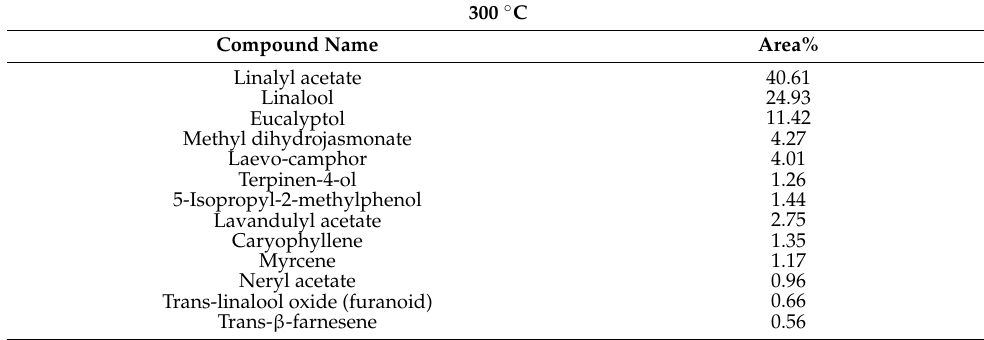
Table 2. Py-GCMS results of LFO at 120 ◦ C.